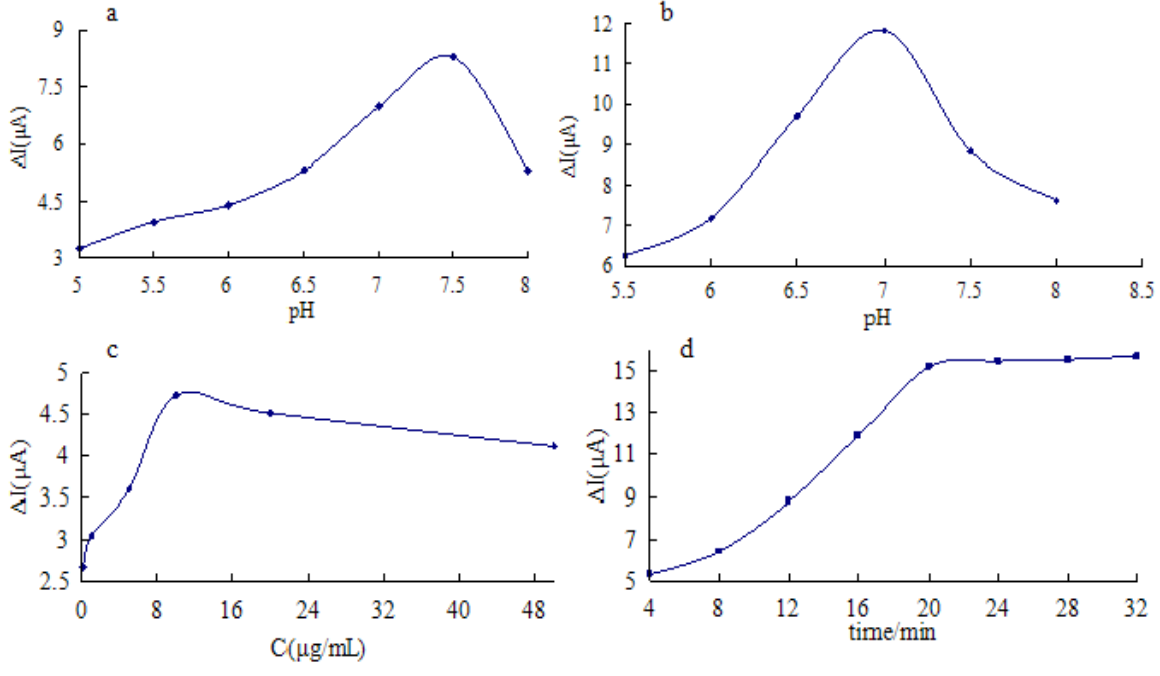
Figure 3. Optimization of experimental parameters: the effect of the pH of the incubation solution on the current response of Ab/SiSG/GCE (a); the effect of the pH of working solution on the current response of Ab/SiSG/GCE (b); the effect of the concentration of Ab on the current response of Ab/SiSG/GCE (c); the effect of the incubation time on the current response of Ab/SiSG/GCE